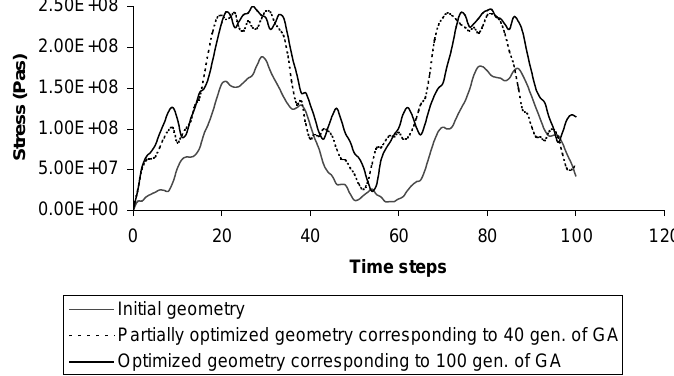
Fig. 7. Maximum Von-Mises stresses vs. time steps for different geometry of the cantilever beam during optimization process.